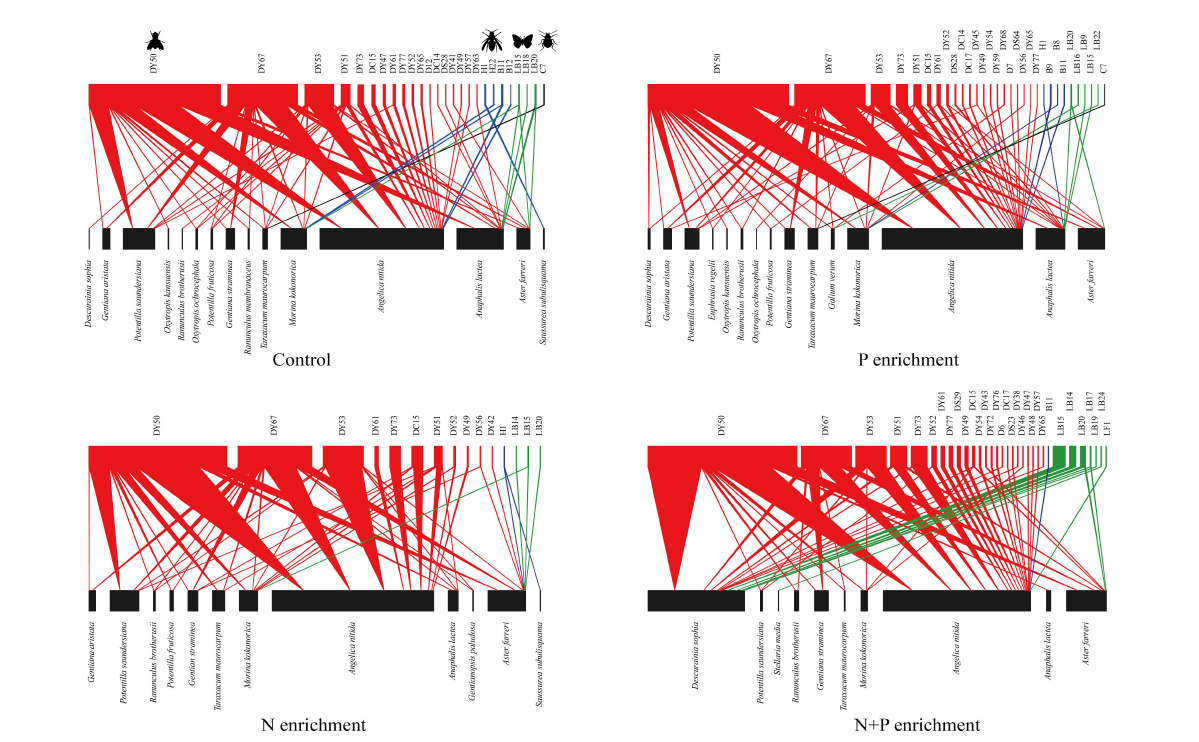
FIGURE2 Plant–pollinator interaction networks for N and P enrichment on an alpine grassland. These pollination networks include flowering plant species (bottom blocks), pollinator species (top blocks), and their pollination interactions (color triangles). The widths of the blocks and triangles reflect the numbers of plants and pollinators or the numbers of pollination interactions, respectively. Colors represent the pollinator groups: green, Hymenoptera; red, Diptera; blue, Lepidoptera; black,